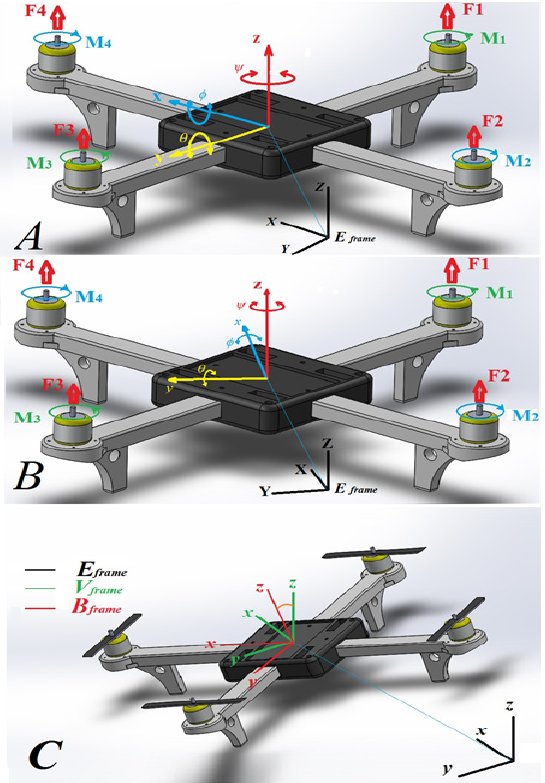
Figure 2. A- Plus quadcopter, B- Cross quadcopter, and C- illustration coordinate